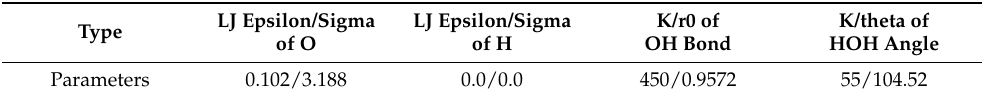
Table 1. Simulation parameters of